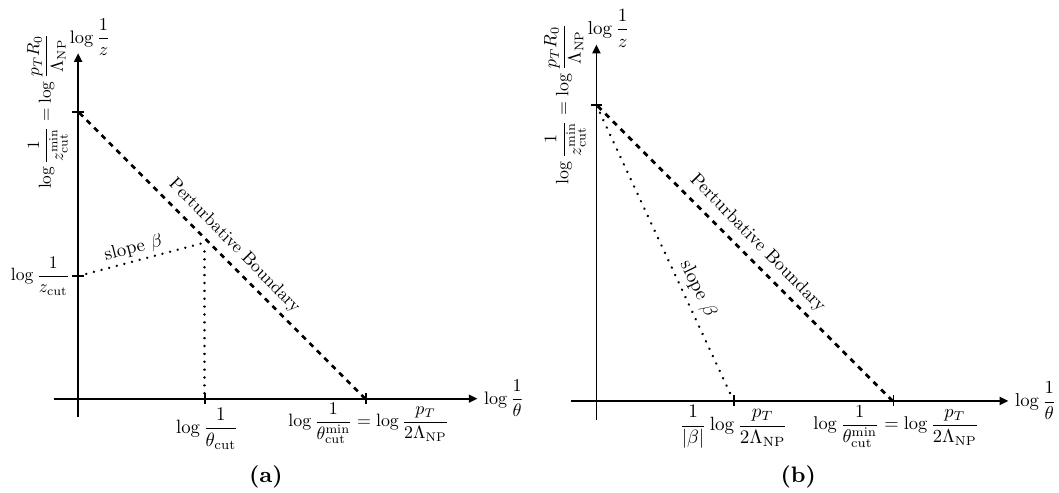
Figure 8. Illustration of the optimal phase space con(cid:12)guration consistent with a perturbative analysis. The dashed line with slope 1 separates perturbative and nonperturbative emissions. (a) (cid:0) For (cid:12) > 1, the value of (cid:18) cut has to be chosen to avoid allowed emissions above the nonperturbative (cid:0) boundary. (b) For (cid:12) < 1, (cid:18) cut can be set to zero, with z cut pushed to the nonperturbative (cid:0) boundary. To maximize the allowed perturbative phase space, one should take (cid:12) = to the optimal value in eq.